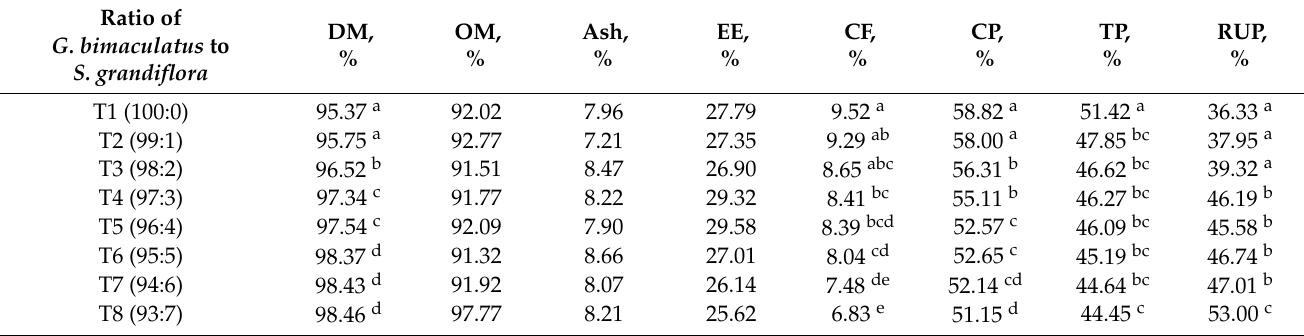
Table 2. Effect of manipulation of in vitro protein degradation from G. bimaculatus powder combined with phytonutrients from S. grandiflora on chemical composition, true protein (TP), and rumen undegradable protein (RUP).